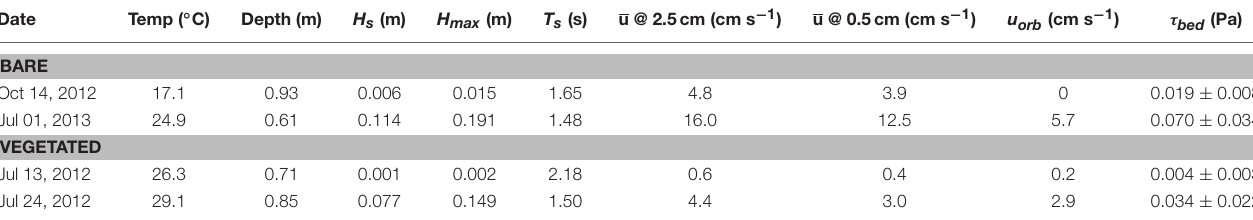
TABLE 5 | Wave properties and environmental conditions for Vectrino profiler deployments with lowest and highest wave activity at the bare and vegetated